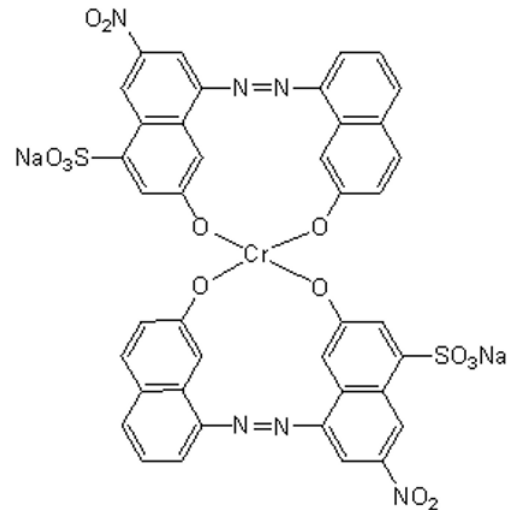
Figure 1. Structural formula of model pollutant azo-dye Colour Index Acid Black ( the standard measurement procedure for photocatalytic activity of samples is carried out with a suspension of TiO containing 1 mg TiO per mL). This standardization 2 2